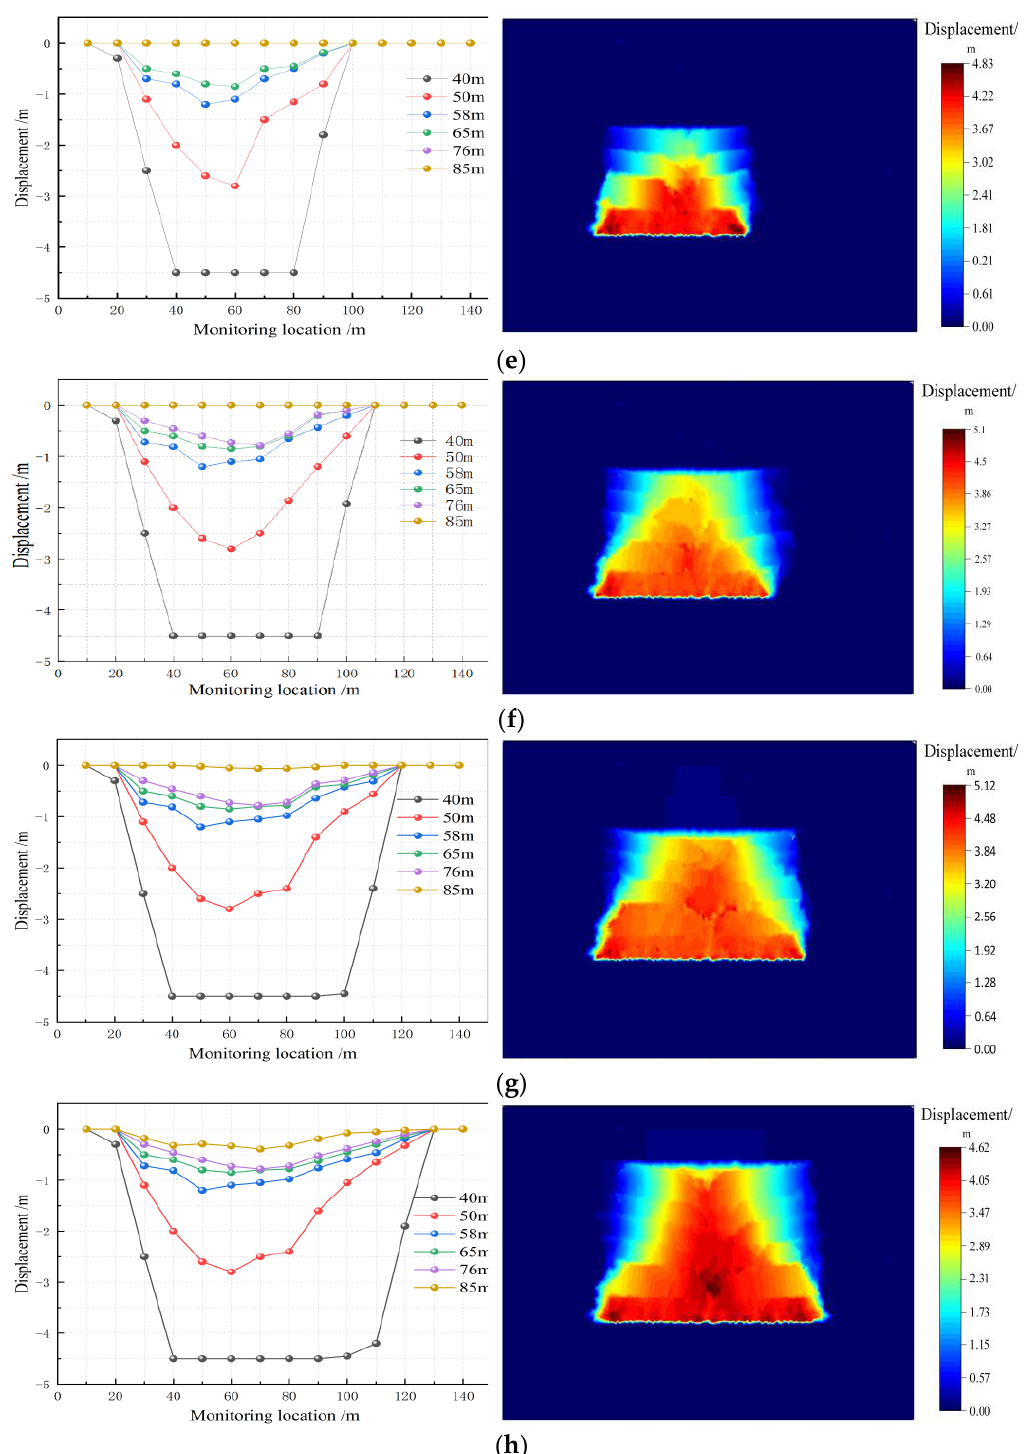
Figure 20. Movement law of overburden rock. ( a ) Working face advancing 20 m vertical displacement; ( b ) Working face advancing 30 m vertical displacement; ( c ) Working face advancing 40 m vertical displacement; ( d ) Working face advancing 50 m vertical displacement; ( e ) Working face advancing 60 m vertical displacement; ( f ) Working face advancing 70 m vertical displacement; ( g ) Working face advancing 80 m vertical displacement; ( h ) Working face advancing 90 m vertical displacement.